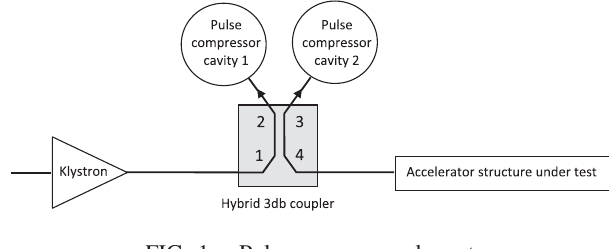
FIG. 1. Pulse compressor layout.